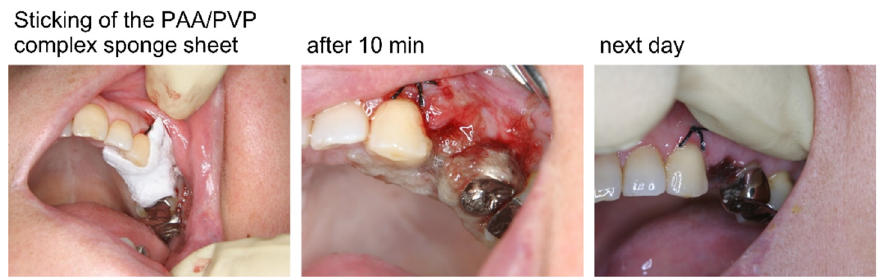
Figure 8. Hemostasis after tooth extraction with a PAA/PVP/HA sponge sheet in the patient taking warfarin (INR